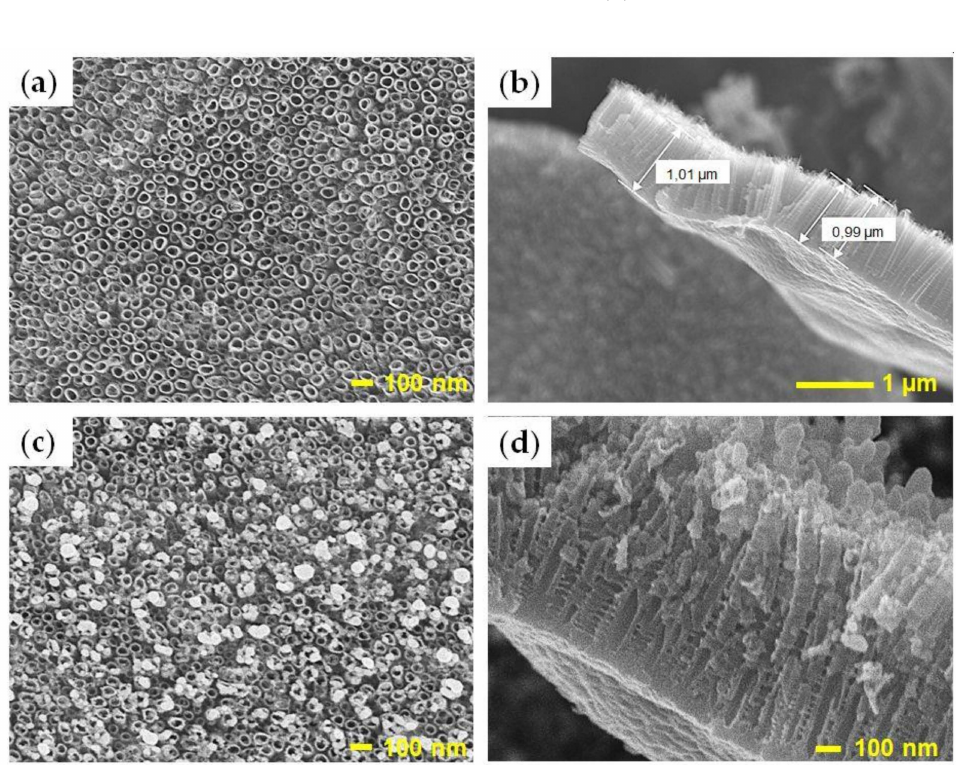
Figure 3. SEM top-view ( a ) and cross-sectional images of annealed TNTs ( b ), top-view ( c ) and cross-sectional images of AgNPs/TNTs ( d